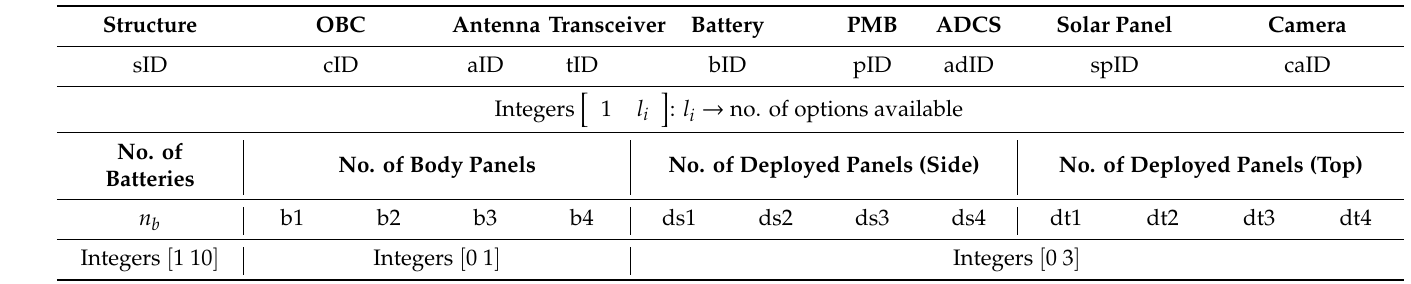
Table 1. Genotype of the CubeSat showing the structure of the gene: subsystem specifier; and specifier for number of batteries, and number and location of solar